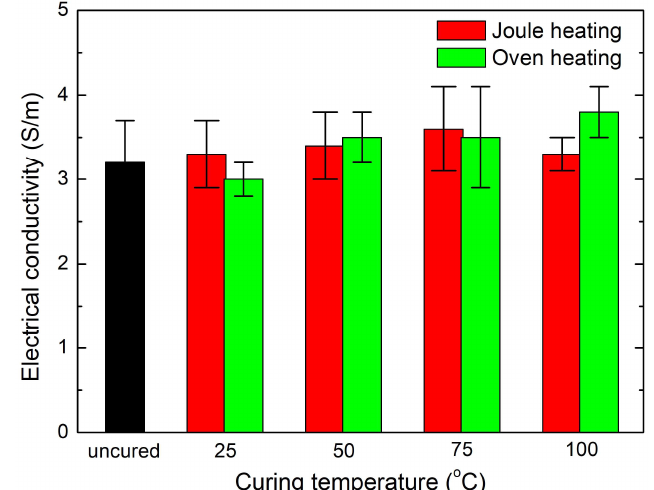
Figure 9. Isothermal differential scanning calorimeter (DSC) curves of CNT nanocomposites cured by Joule heating and oven heating.